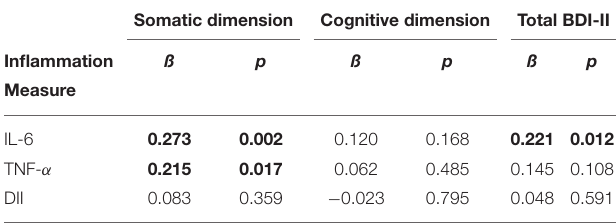
ß: standardized coefficients. Significant associations are highlighted in bold font. All tests were two-tailed. Models were adjusted for age, income, and race/ethnicity. Income was represented as a scale of 1–7, with each point representing one of the seven income groups. Race/ethnicity was represented as four dummy variables, with White as the reference group. Bolded associations p < 0.05.